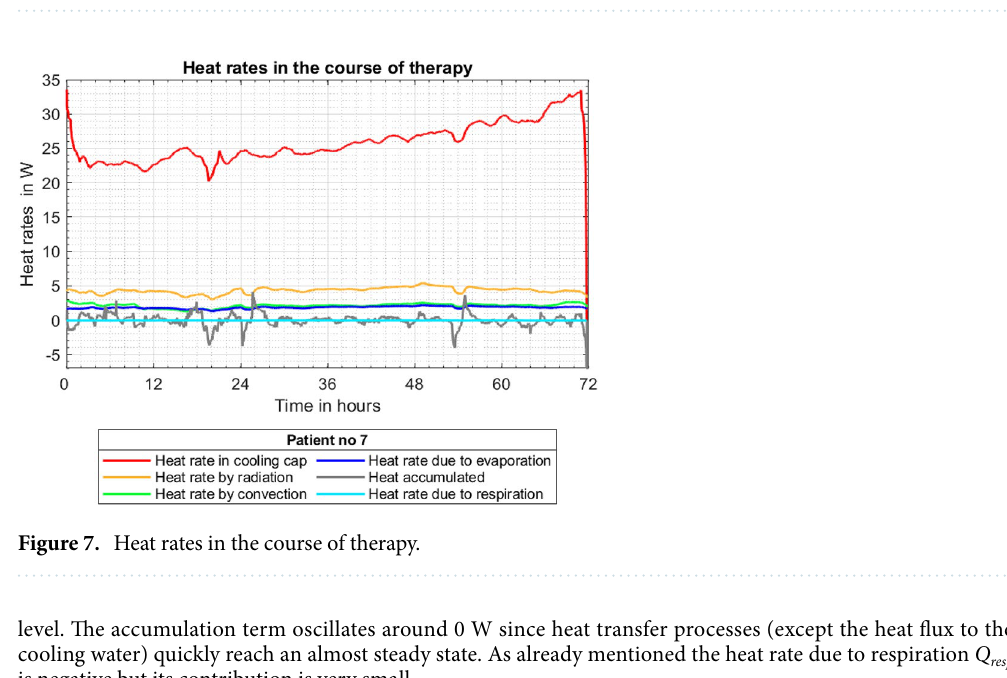
Figure 6. Selected temperatures in the course of therapy.